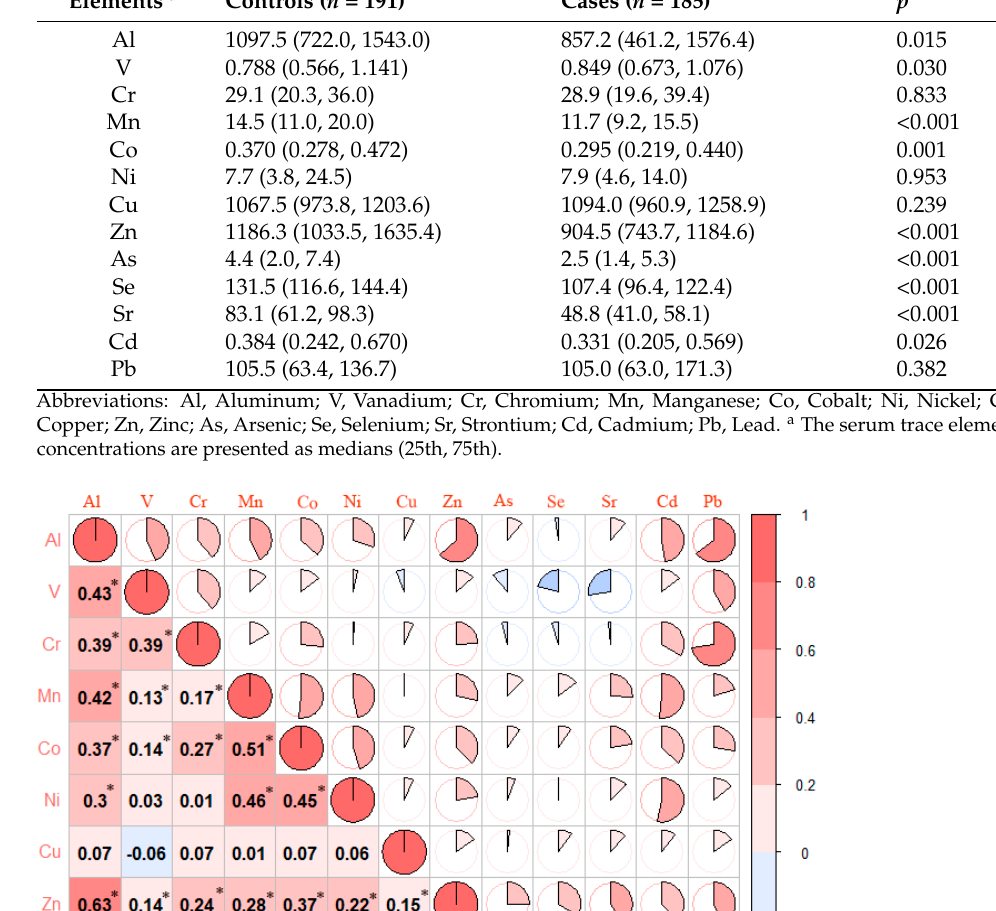
Table 2 . Serum trace element concentrations ( μ g/L) in cases and controls.